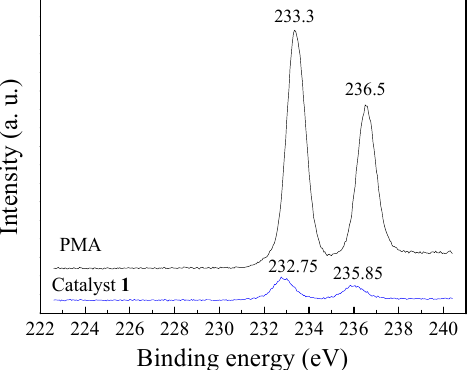
Figure 11. X-ray photoelectron Mo3d spectra of PMA and catalyst 1 Figure 11. X-Ray photoelectron Mo3d spectra of PMA and catalyst 1 .